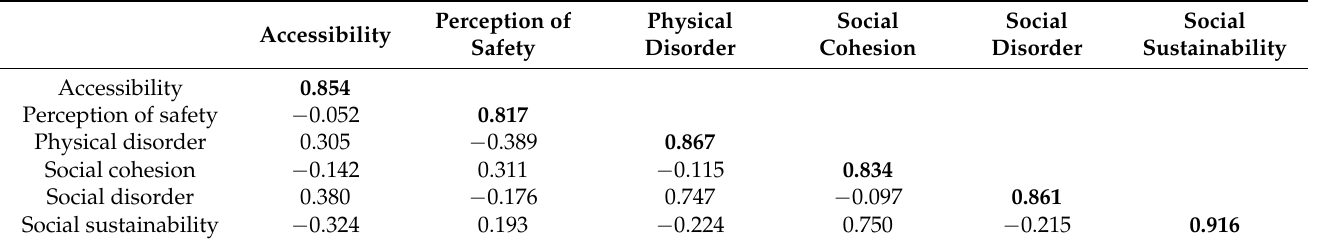
Table 2. Assessment of reliability and validity of